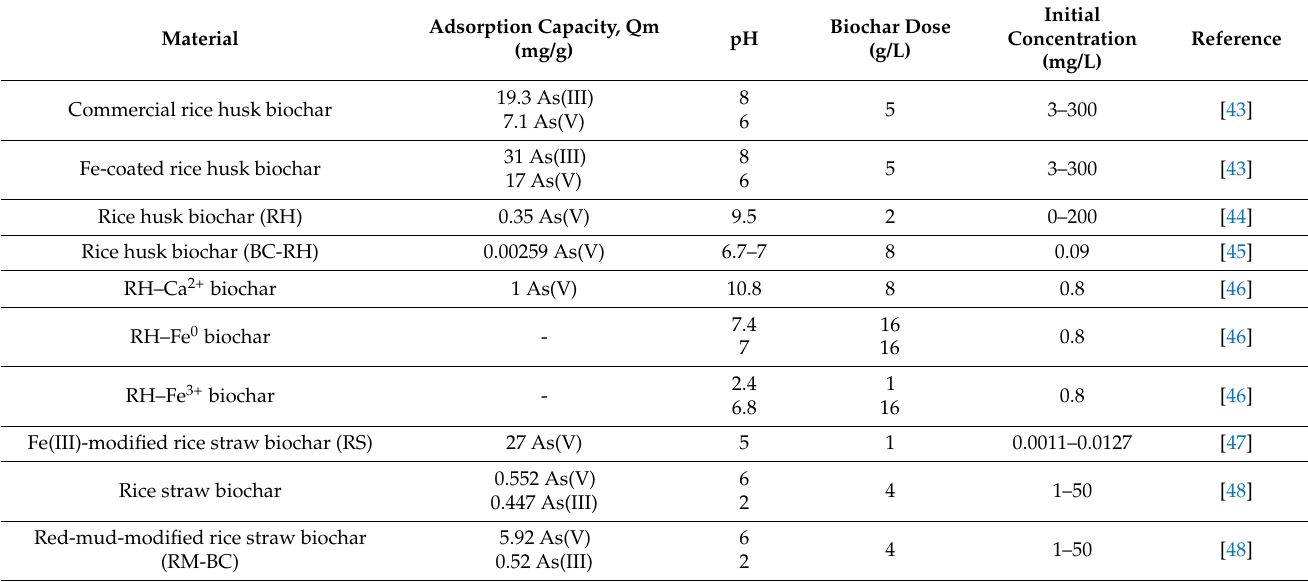
Table 2. Studies on As removal via adsorption on rice husk and rice straw derived